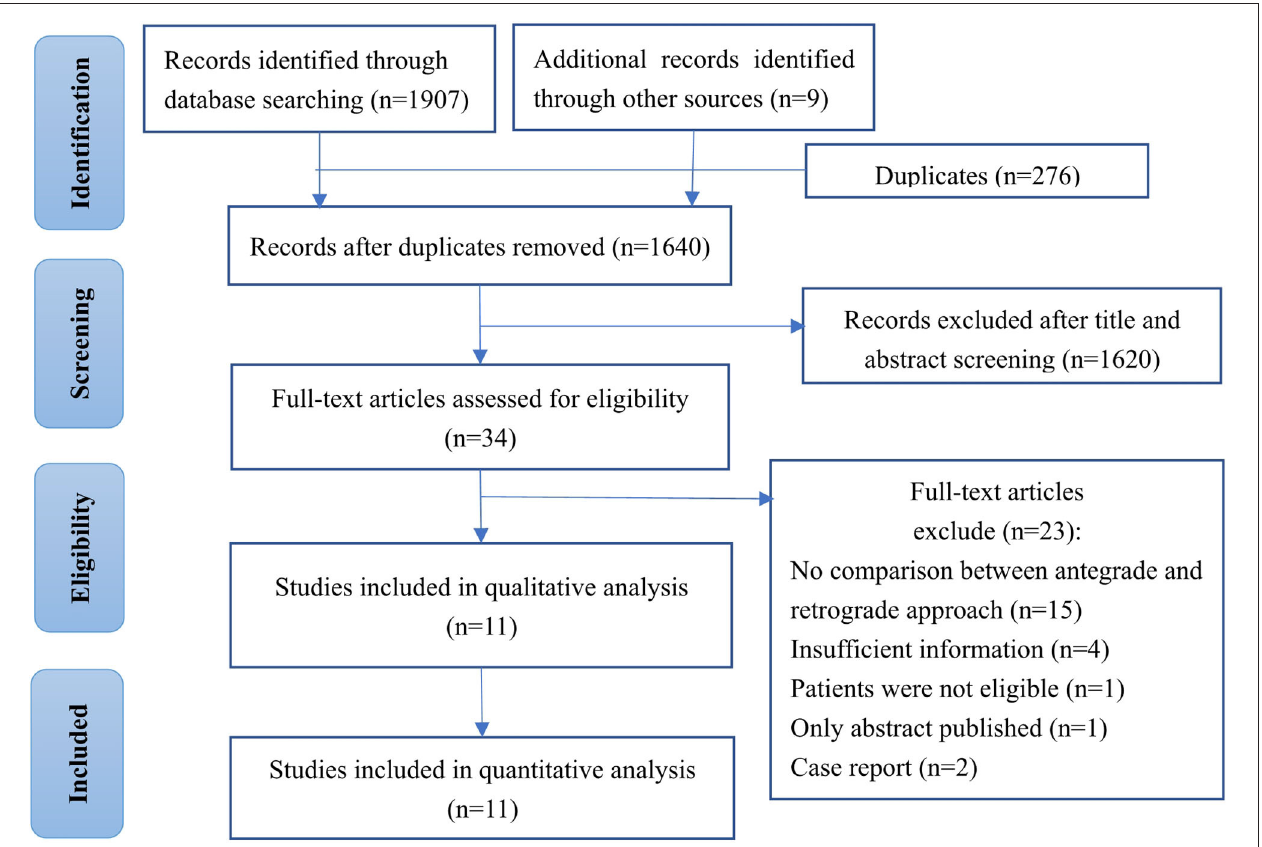
FIGURE 1 | Flow diagram of literature for systematic review and meta-analysis.